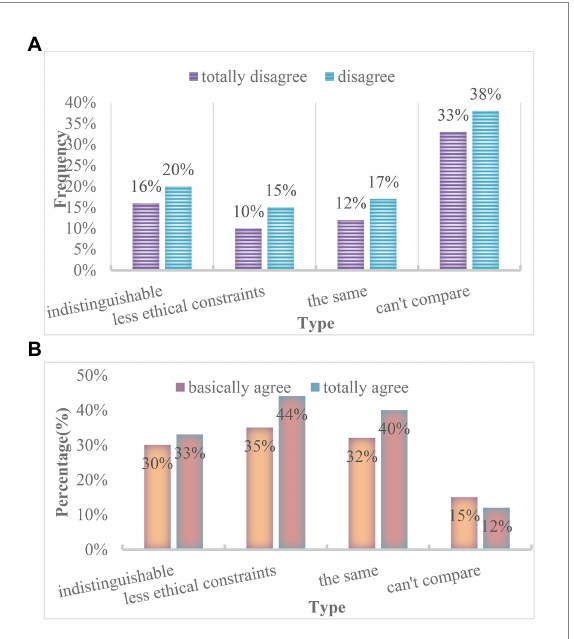
The influence of online education mode on college students’ personality. (A) Freshmen. (B) Senior students.